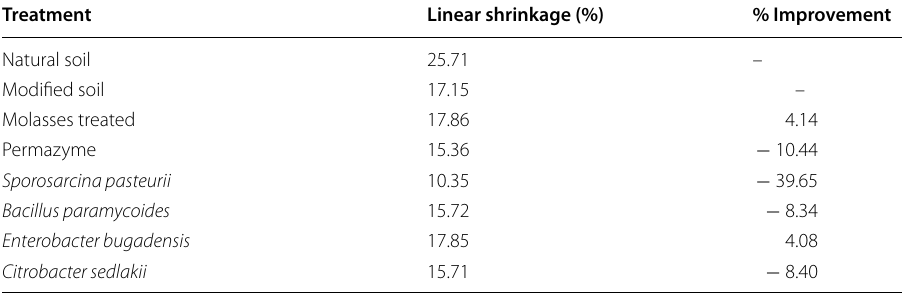
Table 8 Linear shrinkage limit values of natural, modified, molasses and bioenzyme treated modified black cotton